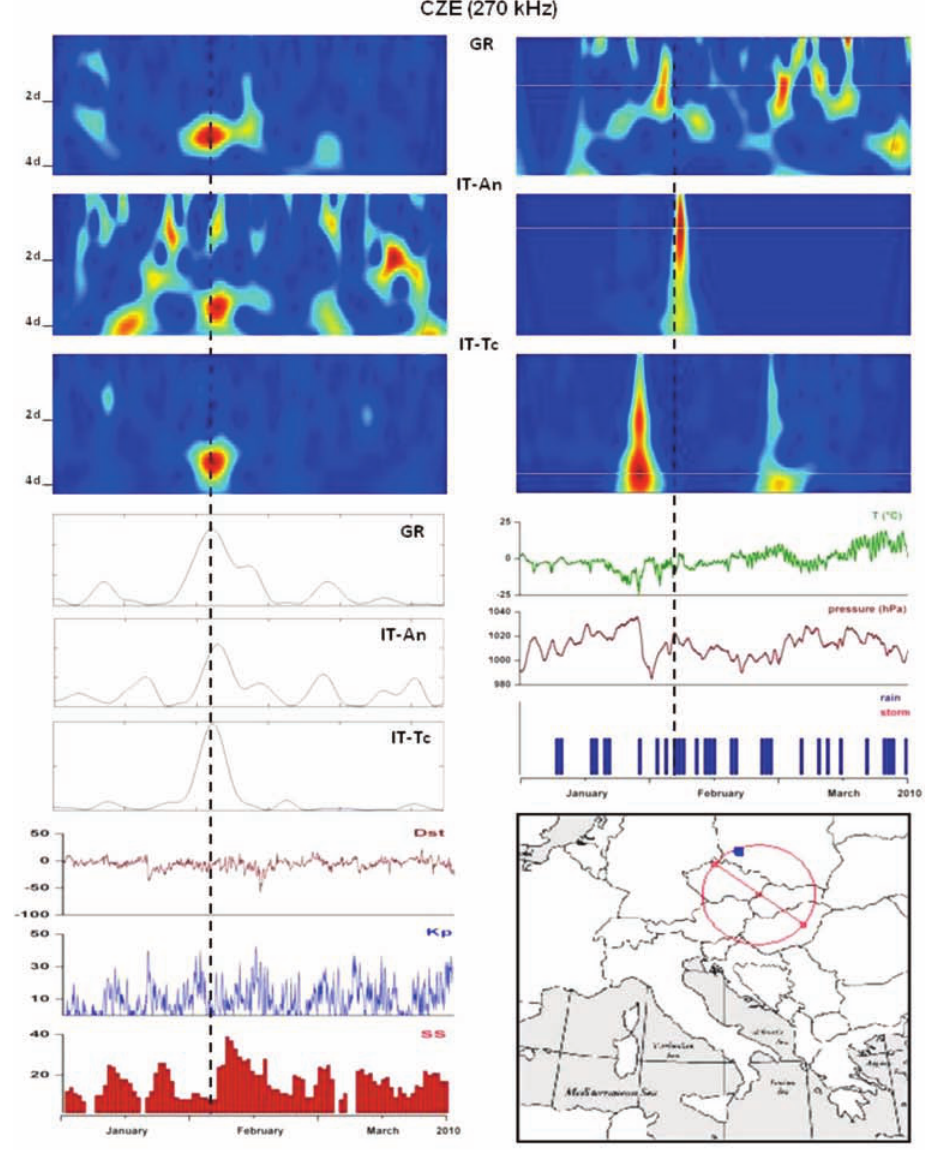
Figure 8. Night-time and day-time spectrograms of the CZE (270 kHz) transmitter radio signals collected by the GR, IT-An and IT-Tc receivers, together with the geomagnetic/solar and the (local) meteorological data, from January to March 2010. Top panels: Spectrograms of the night-time (left) and day- time (right) radio signals. Continuous black lines, delimitation of the region (COI) of the wavelet spectra in which edge effects become important [Torrence and Compo 1998]. Centre left panels: Wavelet powers corresponding to the Fourier period in which the maximum power was found. Bottom left panels: Dst and Kp geomagnetic indices and solar burst numbers (SS). Centre right panels: Air temperature, air pressure and occurrence of rain and storms in the transmitter area. Bottom right panels: Map showing the epicentre of the M = 5.0 earthquake that occurred on February 6, 2010, inside the 300-km radius circle around the CZE transmitter. Vertical dashed lines, time of occurrence of this